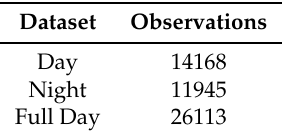
Table 1. Datasets created from Depresjon